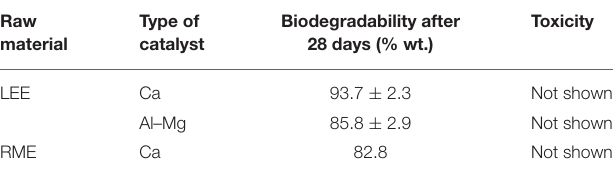
TABLE 6 | Eco-evaluation of ethoxylated products. Raw